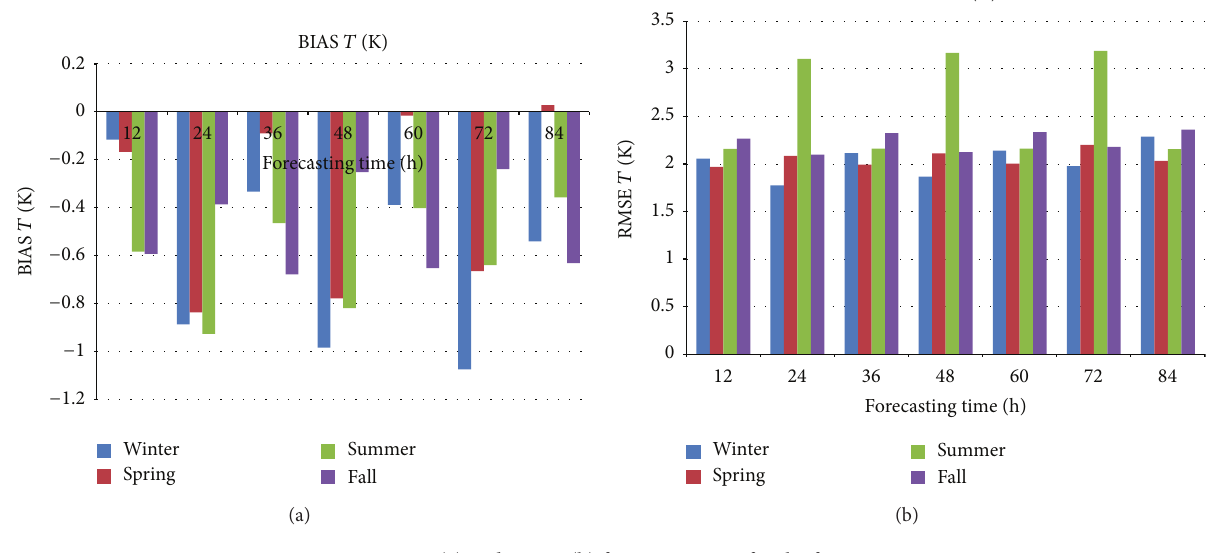
Figure 3: BIAS (a) and RMSE (b) for temperature for the four seasons.